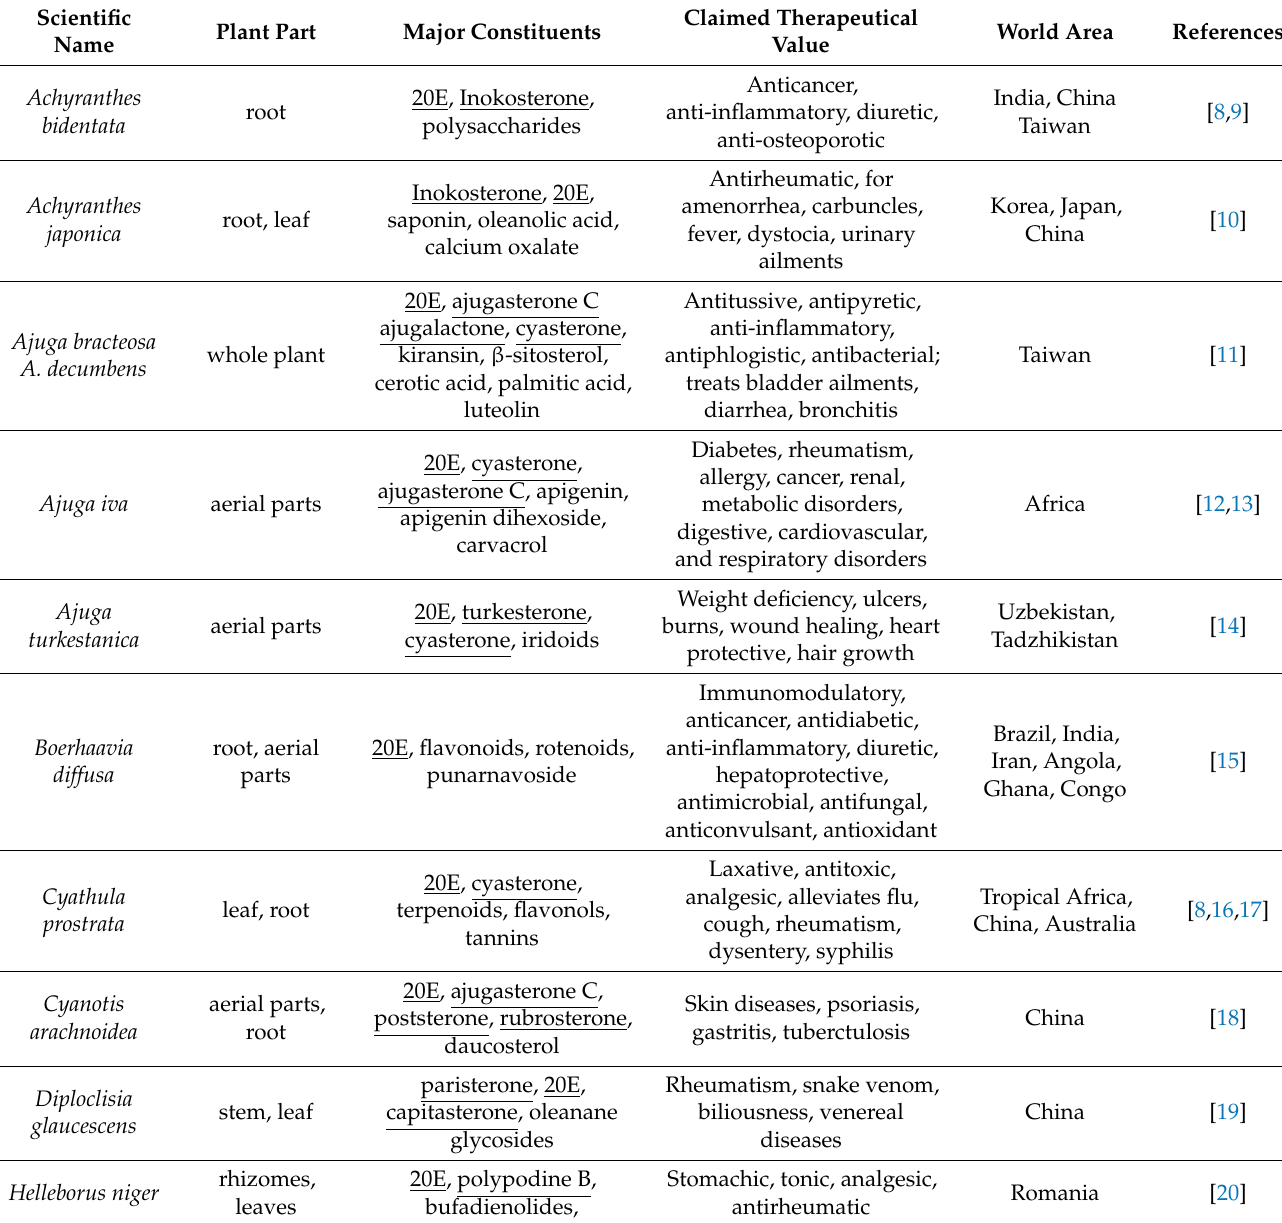
Table 1. Selected examples of ecdysteroid-rich medicinal plants and their traditional uses. The names of ecdysteroids are underlined (see www.ecdybase.org for structures, accessed on 1 April 2021). Note that it is not established that all the reported biological activities are due totally or partly to the presence of